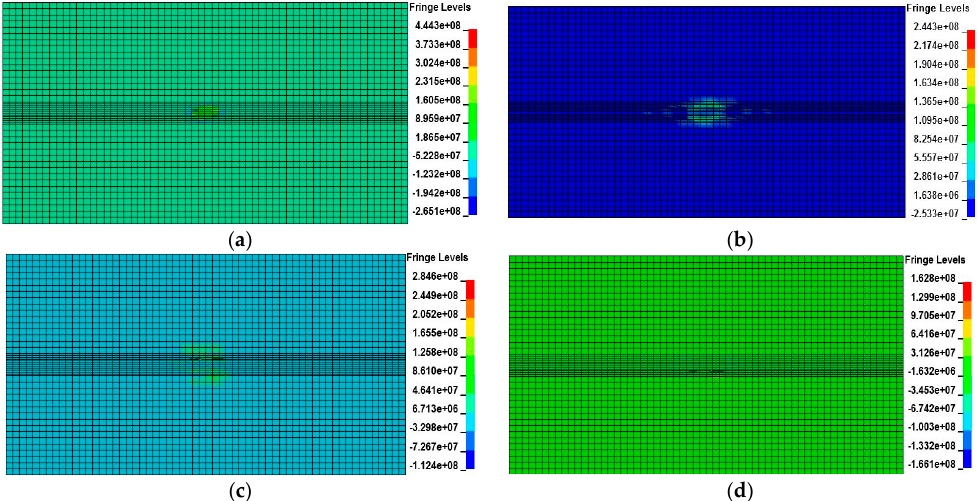
Figure 11. Pressure contours in several typical moments. ( a ) t = 0.099 µs; ( b ) t = 0.4 µs; ( c ) t = 1.5 µs; ( d ) t = 2 µs.